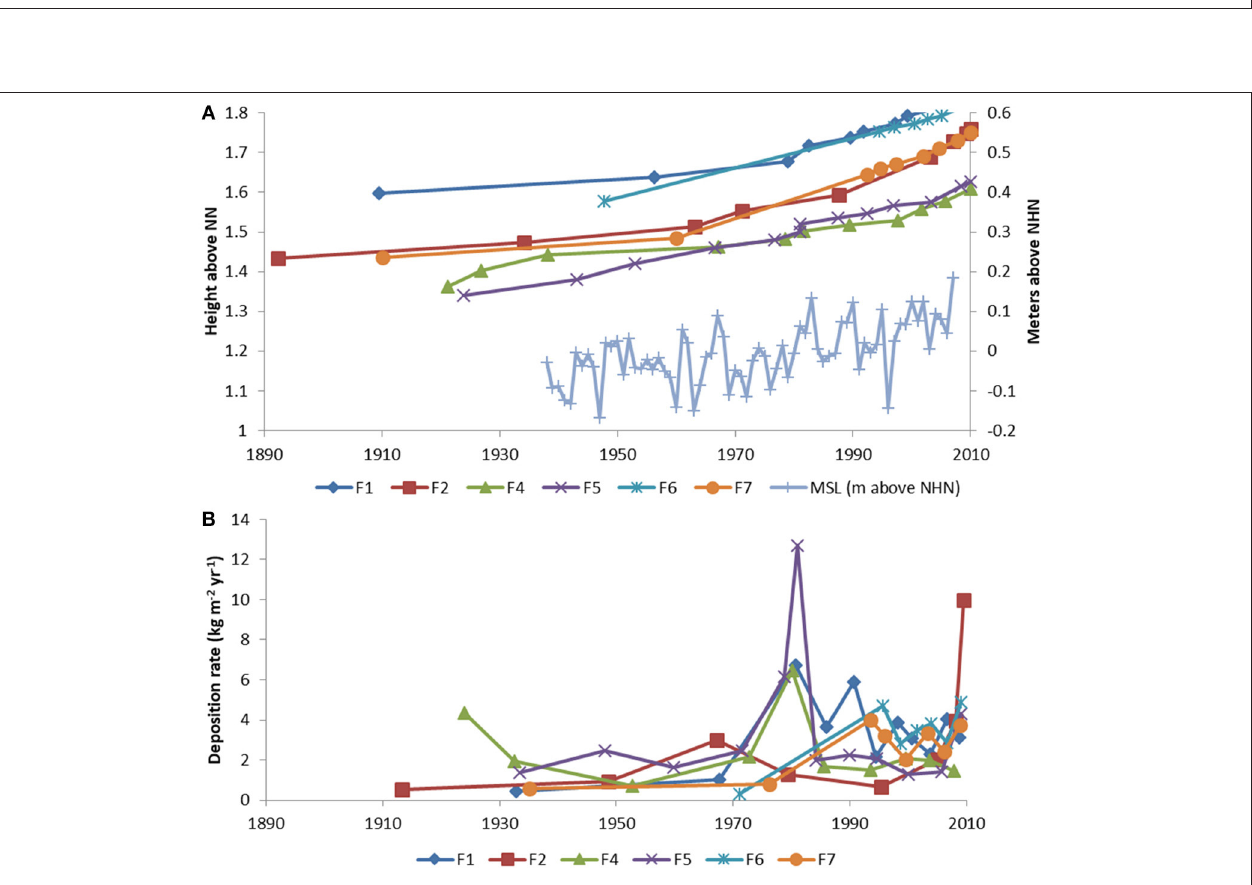
FIGURE 7 | (A) Historic evolution of the marsh surface elevation (m above NHN) from 1890 to 2010 for the cores F1, F2, F4, F5, F6, F7 in comparison to the annual average of the mean sea level in Hoernum harbor. (B) Time series of sediment deposition rates within the same time period.